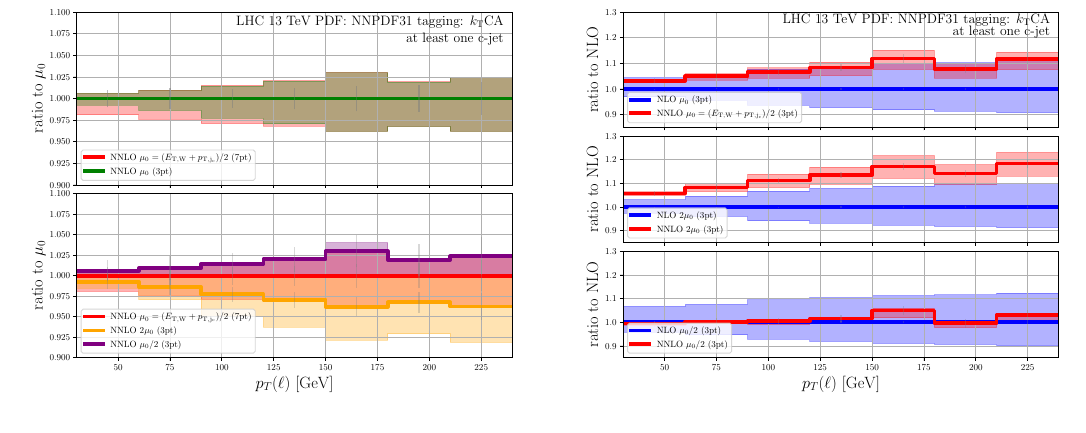
Figure 4 . Ratios of differential distributions in the transverse momentum of the charged lepton for √ the process pp → W + j at s = 13 TeV. Left: a comparison of 7-points and 3-points scale variation c for the nominal scale (top) and a comparison of different central values with 3-points scale variation (bottom). Right: a comparison of NNLO K -factors for different central scales with 3-points scale variation.